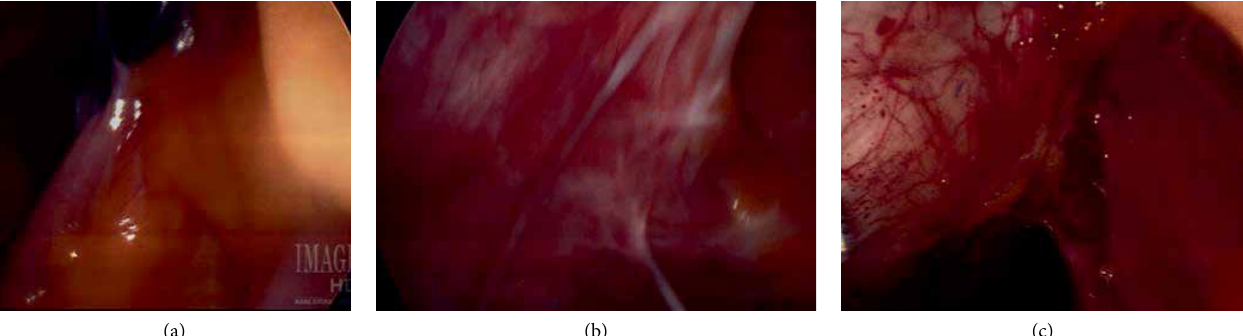
stain).Figure 2: Intraoperative images: (a) adhesion of bowel and omentum to anterior abdominal wall; (b) white patches of endometriotic implants; (c) endometriotic implants on the large bowel (left), adhesions of omentum to large bowel